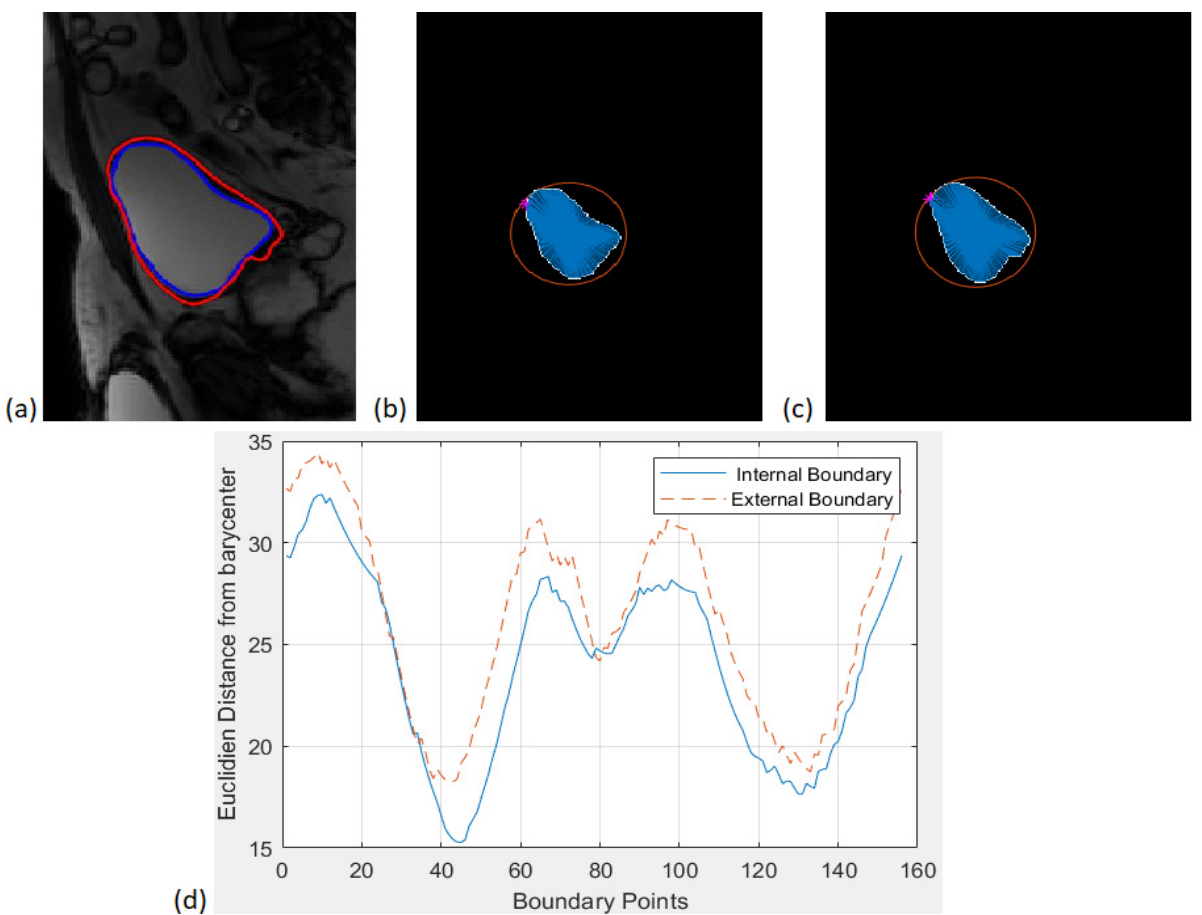
Figure 4. ( a ) An example of LevelSet bladder wall segmentation. ( b ) Matching the bladder’s barycenter with each point of the internal boundary. ( c ) Matching the bladder’s barycenter and each point of the external boundary. ( d ) Euclidean distance between the barycenter and both of the inner and outer contours.